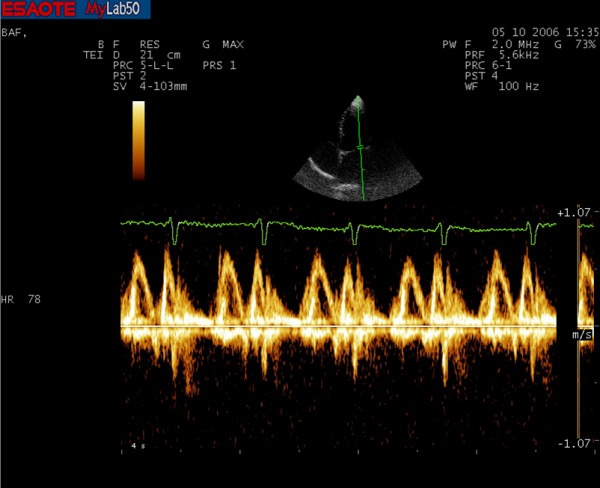
Conventional PW Doppler spectrum of an hypertensive subject.